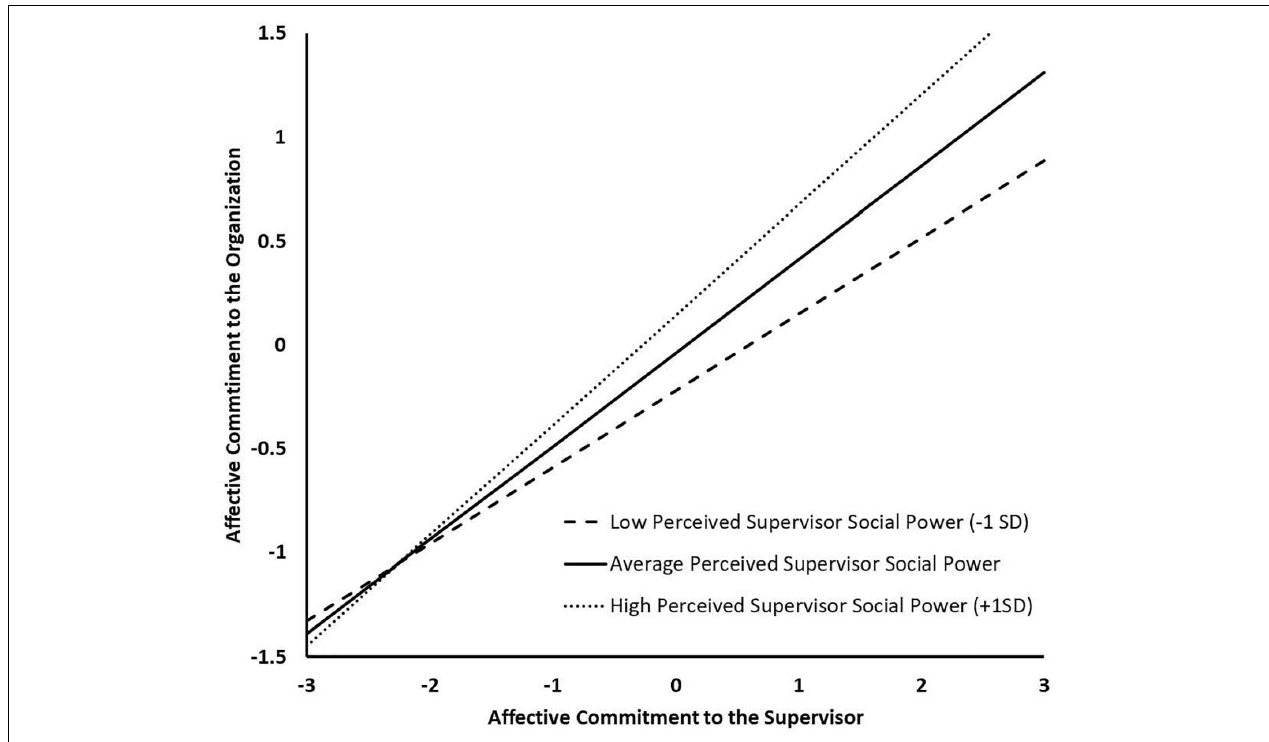
FIGURE 2 | Study 2 Simple Slopes for the Moderation Effect of Perceived Supervisor Social Power between Affective Commitment to the Supervisor and Organizational Commitment.